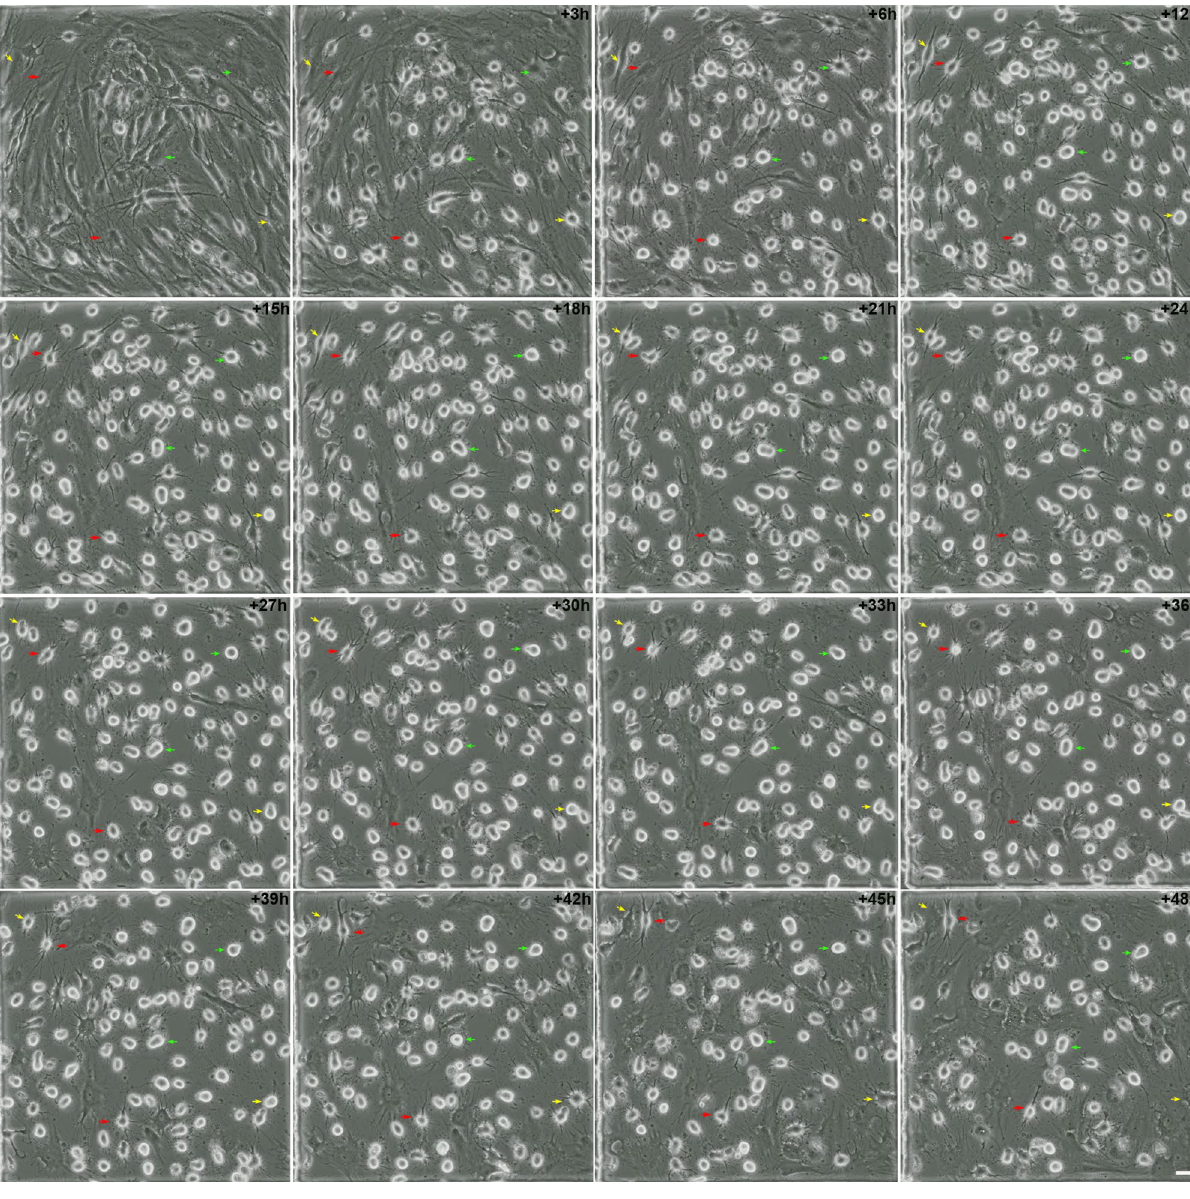
Figure 1. Morphological changes in hBM-MSC cultures during neural-like differentiation. Time-lapse imaging revealed that, following neural induction, hBM-MSCs rapidly reshaped from a flat to a spherical morphology (intermediate cells). Subsequently, we observed that hBM-MSC-derived intermediate cells can preserve their spherical shape for several days (green arrows), change to that of neural-like cells through active neurite extension (red arrows) or revert back to the mesenchymal morphology (yellow arrows). Scale bar: 25